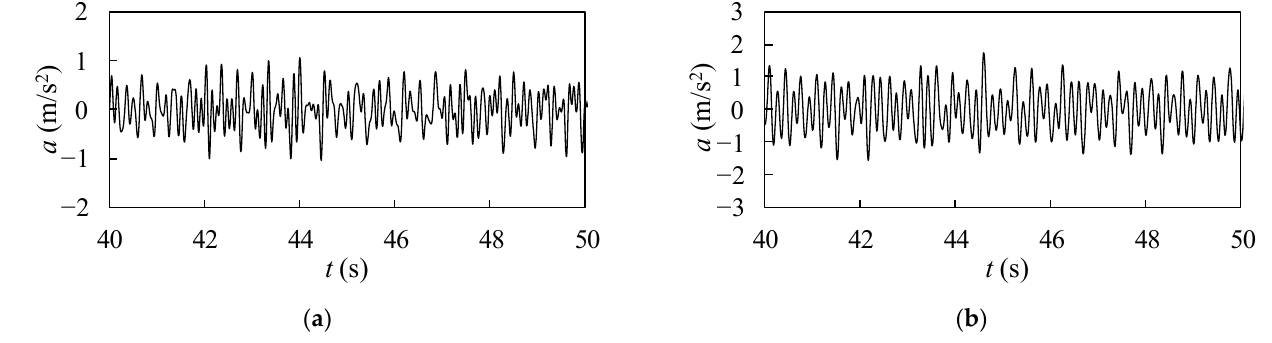
Figure 4. Acceleration dynamic response of the system. ( a ) DOF 3; ( b ) DOF 4.